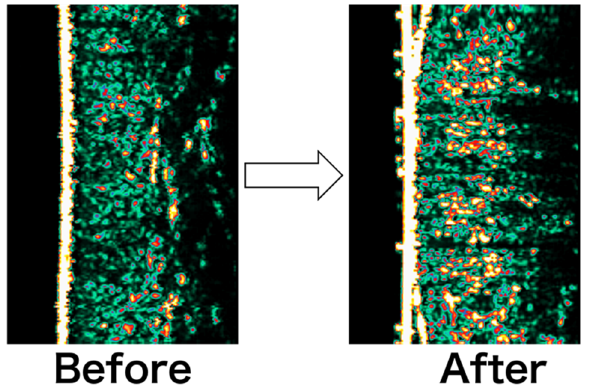
Figure 4. Before ( left ) and after ( right ) applications of vibrotactile sensations transformed, according to the Tactile Score, to the skin using DermaLab to measure skin ultrasound cross-sections and to investigate the distribution of collagen fibers in the dermal layer. The dots in the figure are collagen fibers.